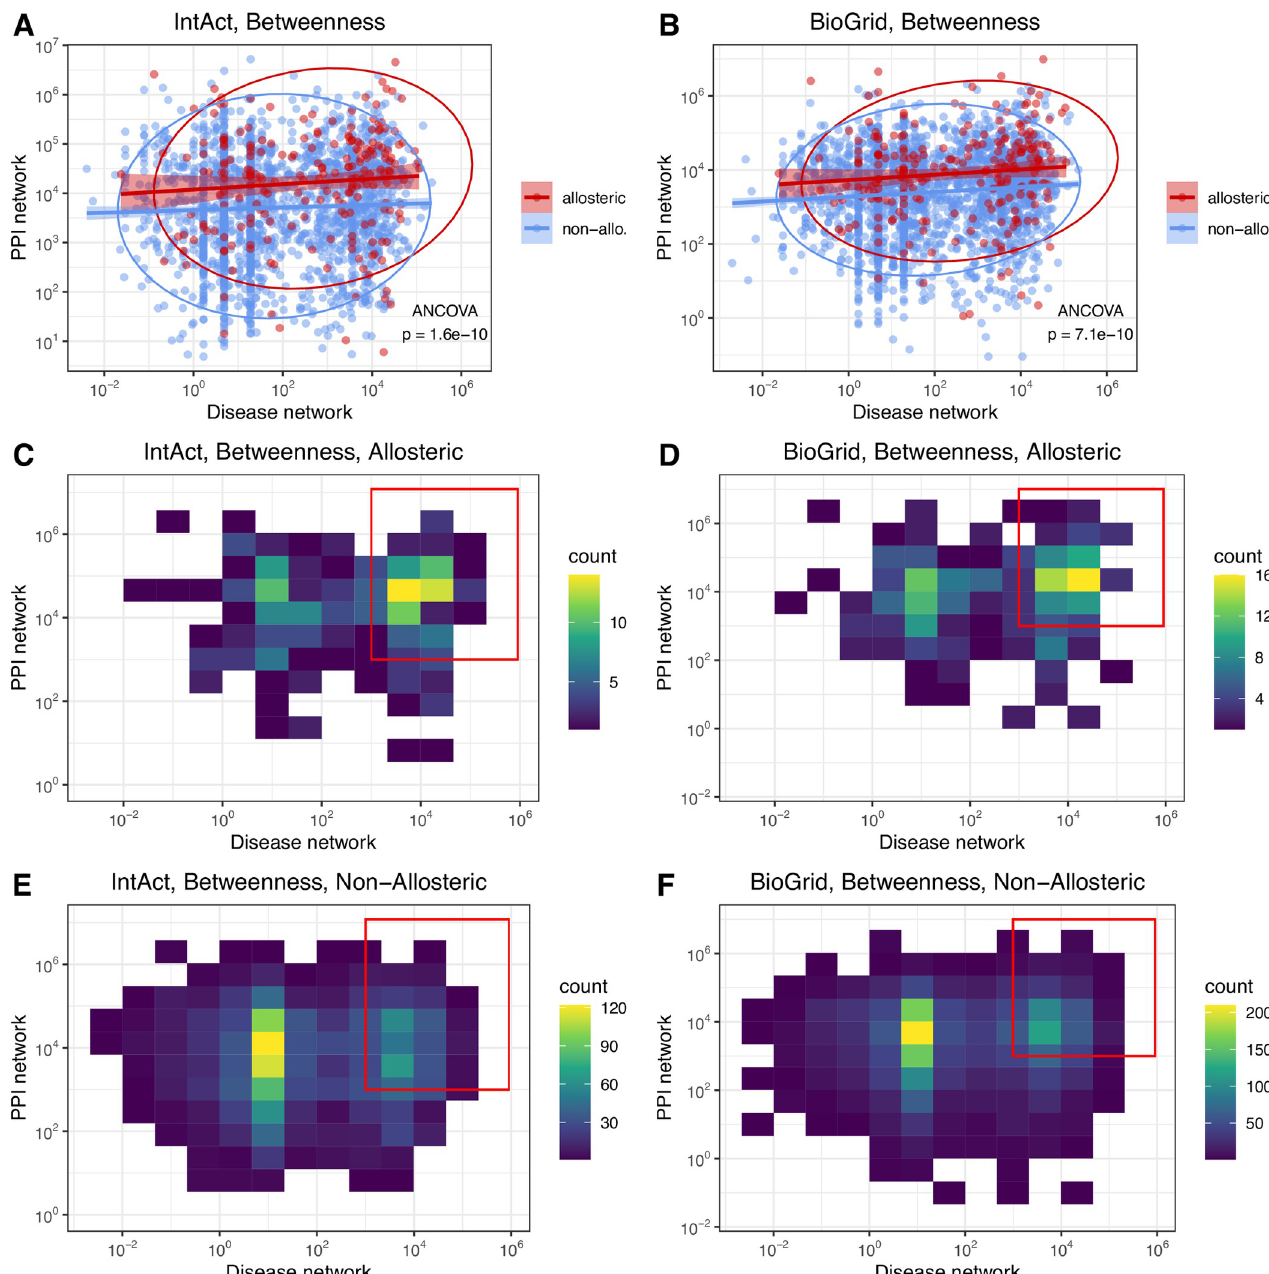
Fig 7. Allosteric proteins have higher betweenness both in PPI and disease networks than non-allosteric proteins, even though the overall correlation between the centralities of the two network types is weak. A-B) Correlations between PPI and disease protein network centralities. Proteins with 0 betweenness centrality in any of the two networks were excluded. C-D) Density plots of allosteric proteins. 43.5% (IntAct) and 39.9% (BioGrid) of proteins have betweenness centrality higher than 1000 in both networks (red rectangle). E-F) Density plots of non-allosteric proteins. 23.6% (IntAct) and 23.3% (BioGrid) of proteins have betweenness centrality higher than 1000 in both networks (red rectangle). Data ellipses on panel A and B were drawn with the stat_ellipse() function of ggplot2 (R), with default settings, ANCOVA was performed on log transformed